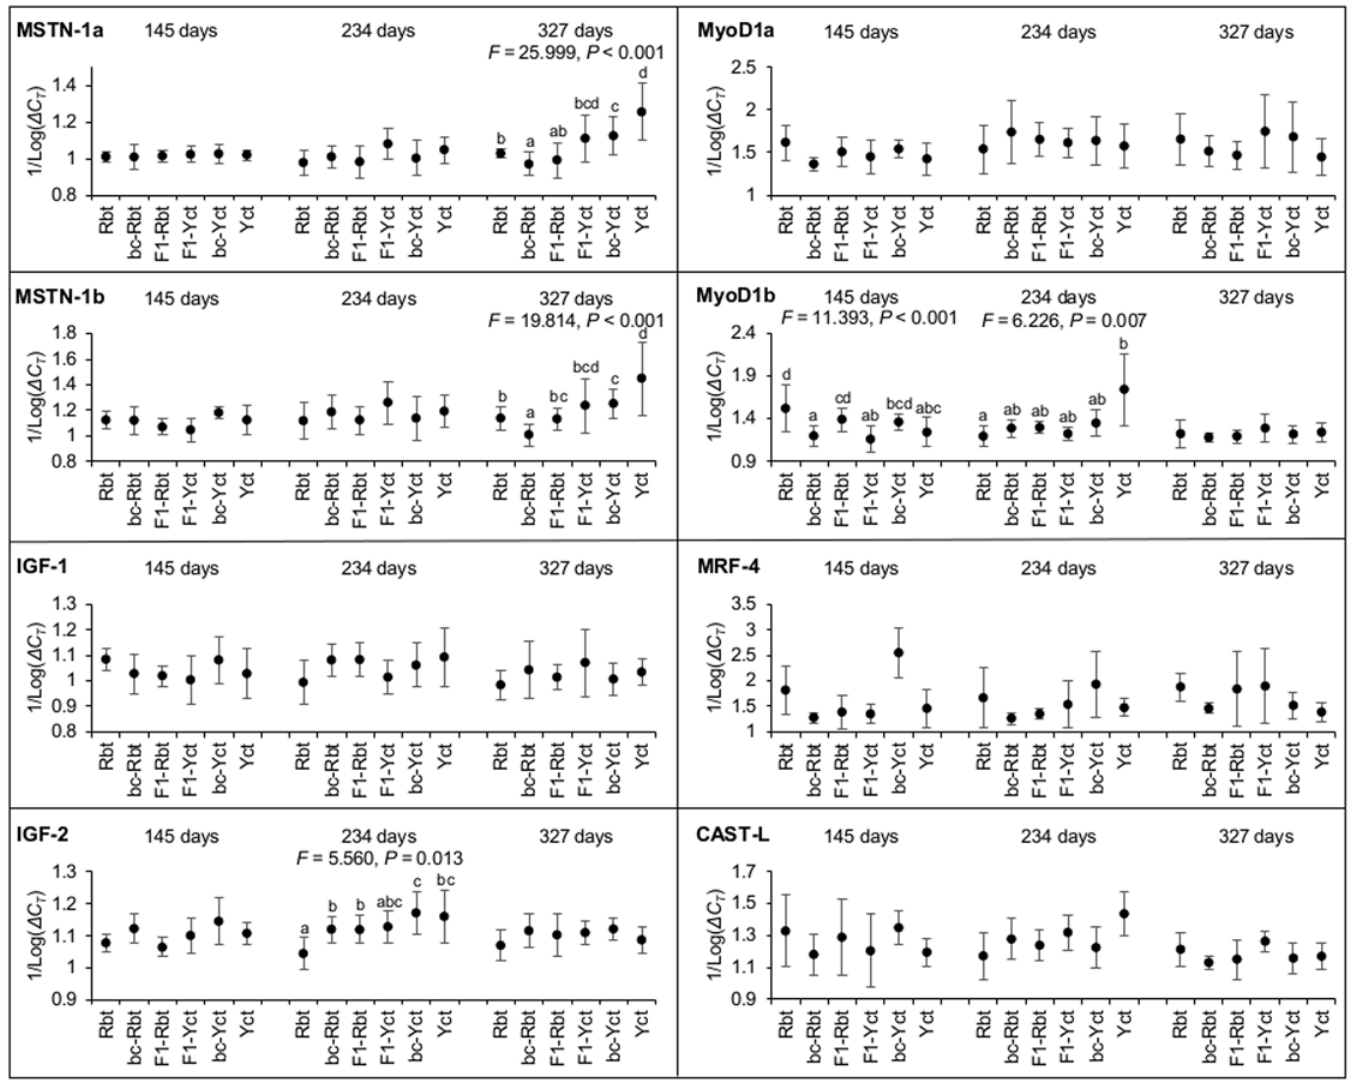
Fig 3. Transcript abundance ( ± SD) of eight muscle growth-related genes among crosses at 145, 234, and 327 days post-fertilization. Significant PERMANOVA tests are indicated (pseudo- F and P -value) and lowercase letters indicate significant differences ( P < 0.05) in expression between crosses in post-hoc tests. Rbt = rainbow trout, bc-Rbt = first generation Rbt backcross, F1-Rbt = F1 hybrid with Rbt maternal lineage, Yct = Yellowstone cutthroat trout, bc-Yct = first generation Yct backcross, and F1-Yct = F1 hybrid with Yct maternal